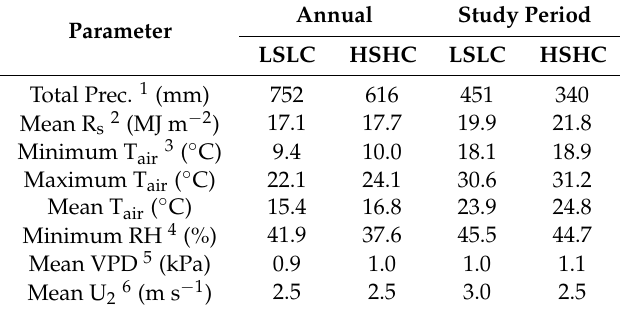
Table 2. Twenty-year (1997–2016) average annual and study period (July to October 2017) meteorological parameters obtained from Oklahoma Mesonet weather